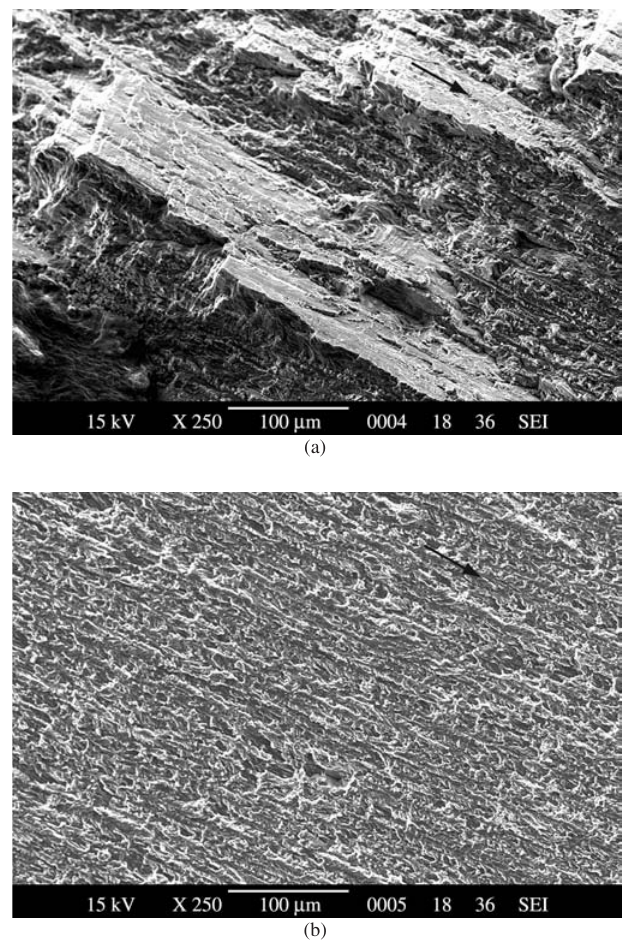
Figure 8. SEM fractography of Al 8090 alloy of a) low ∆ K region; and b) high ∆ K region. 250X. Arrow indicates the direction of crack